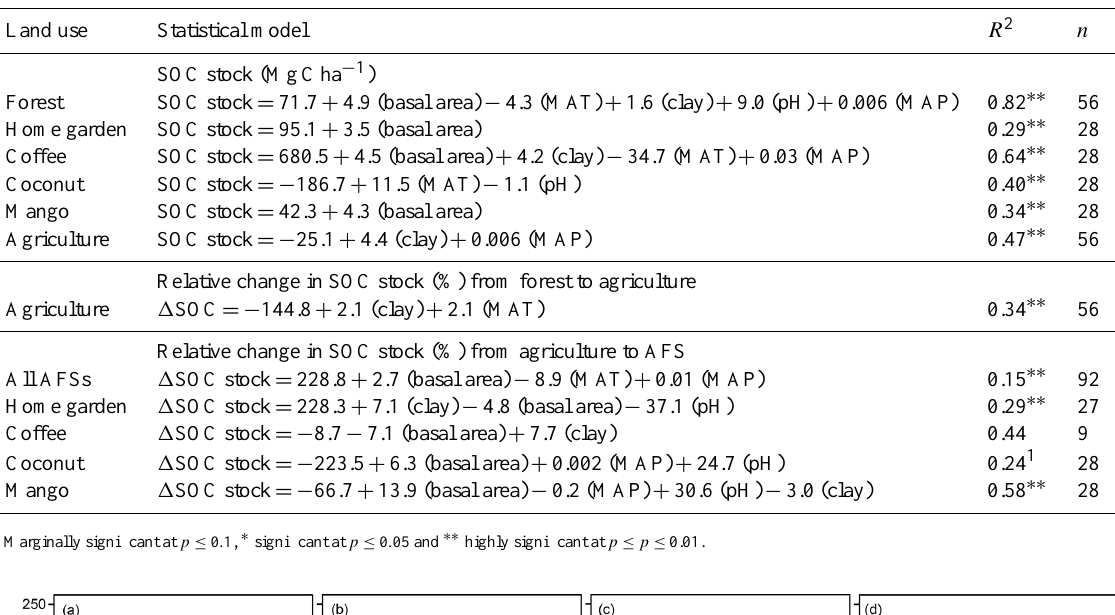
Figure 4. Scatterplots (a-d) showing the relationship forest SOC stock (top 1m) exhibits with 2 MAP (mm), basal area (m 2 ha -1 ), soil texture (clay percent), and soil pH across humid (  ), 3 moist-sub-humid ( ), dry sub-humid ( ) and semi-arid (+) climate zones. Scatterplots (e-h) 4 show the relationship SOC stock changes (from agriculture reference) have with the same 5 soil and biophysical variables in homegarden ( ), coffee ( ), coconut ( ) and mango ( ) 6 AFSs. 7